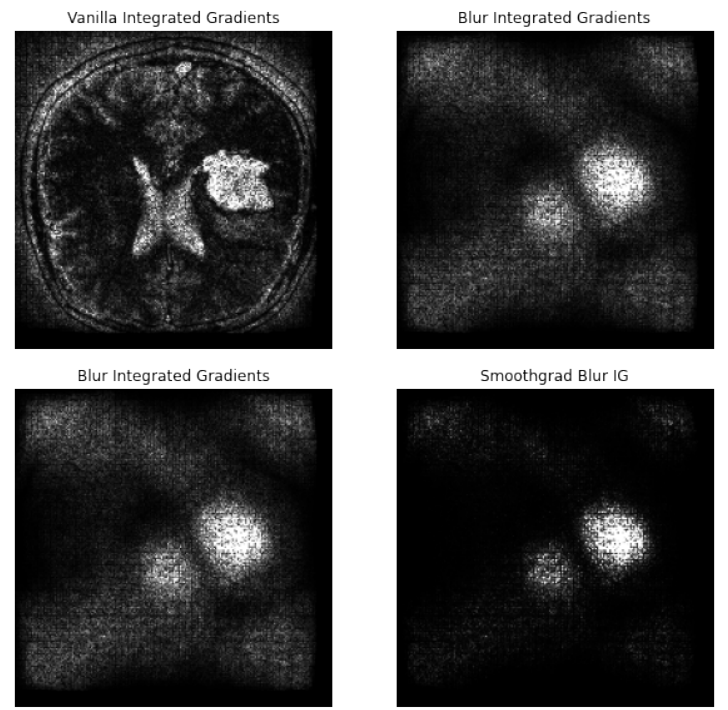
Figure 13. Blur integrated gradients and SmoothGrad IG